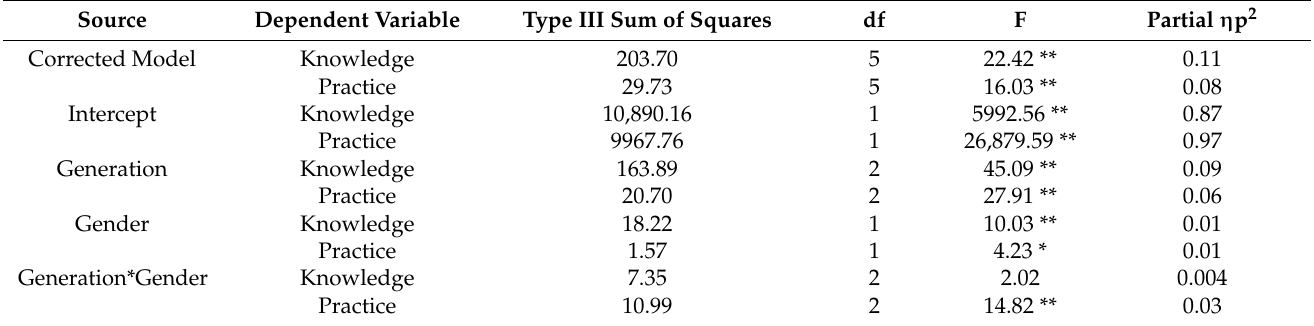
Table 4. Multivariate analysis of variance of food safety knowledge and practices by gender and